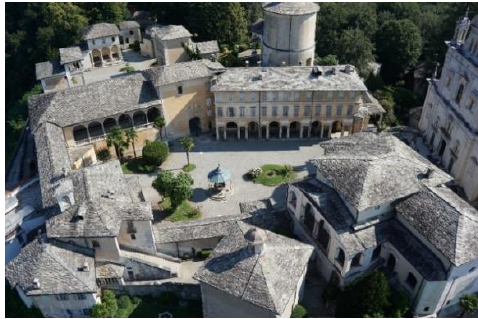
Figure 1. Complex of the Sacro Monte of Varallo.